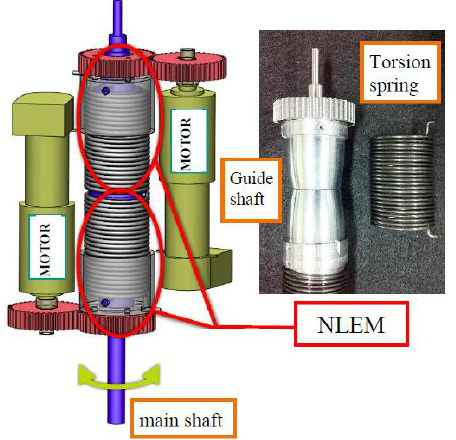
Figure 3. Rotary type ANLES ( r-